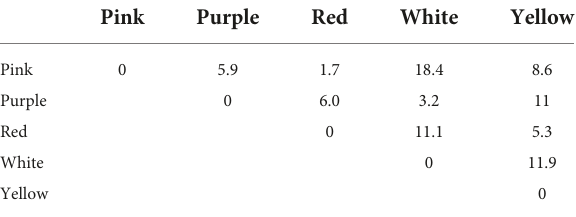
TABLE 1 Separation between color clusters belonging to different human categories assessed as the ratio of the distance between mean of the clusters to the standard deviation along the line of the best separation (Eq.